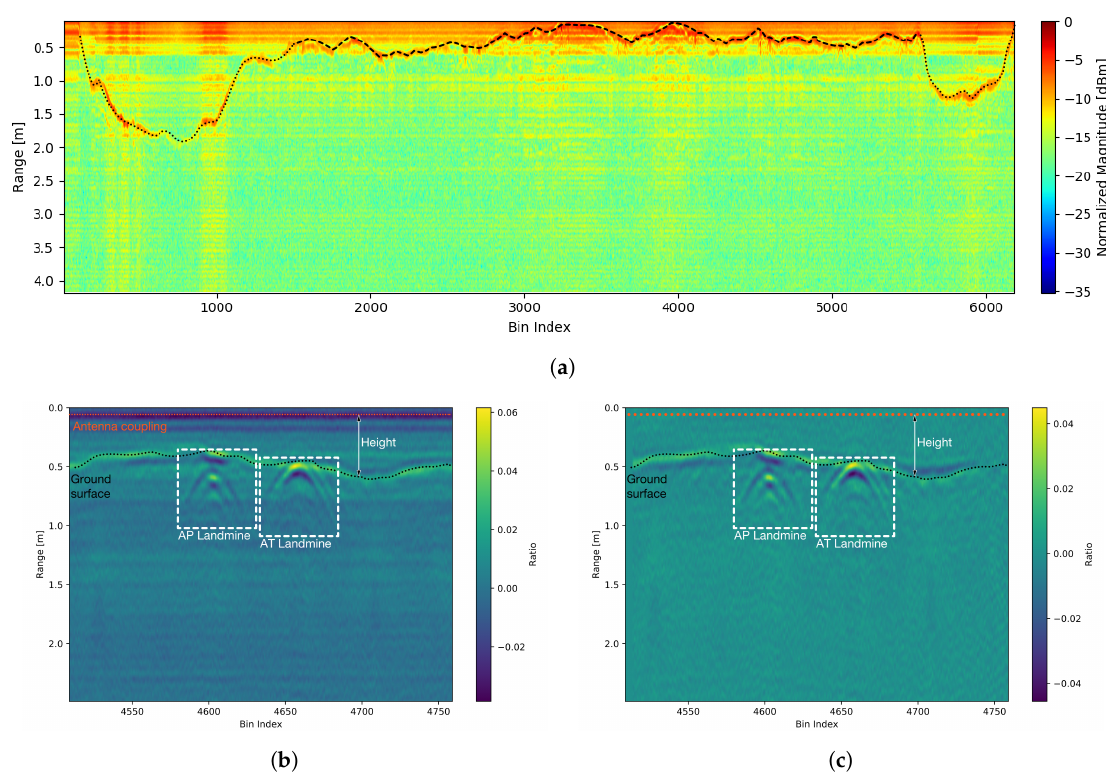
Figure 14. ( a ) Radargram of complete flight with UAV where scanning is visible (dashed black line) and also take-off and landing (dotted black line); ( b ) radargram of basic processed data with depicted landmines ( c ) radargram with background